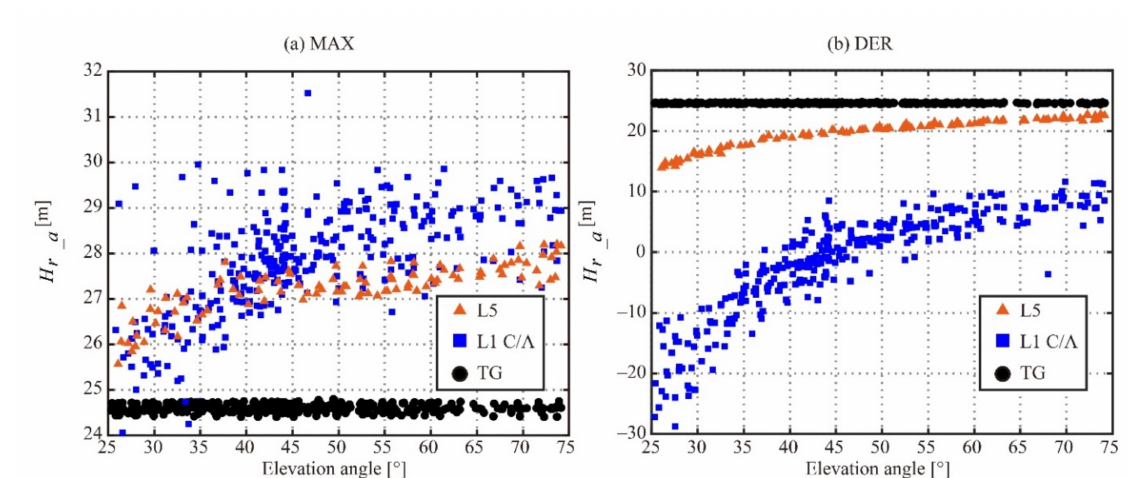
Figure 7. Scatter plot of the first ocean altimetry results obtained using the above-mentioned GNSS-R ocean altimetry method. ( a , b ) are the height of the coastal receiver relative to the sea surface obtained using different signals and types of the characteristic points, according to Equation (2).